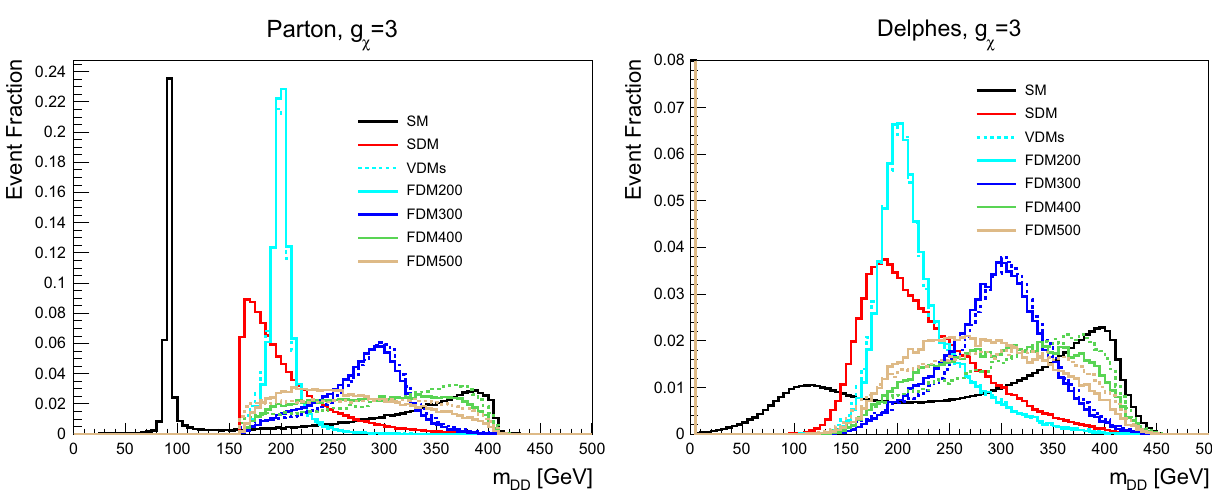
Fig. 4 Invariant mass of DM (neutrino) pair for signal (background). The left panel shows parton level distributions. Right panel shows the detector level distributions. The meaning of the lines is the same as in Fig.